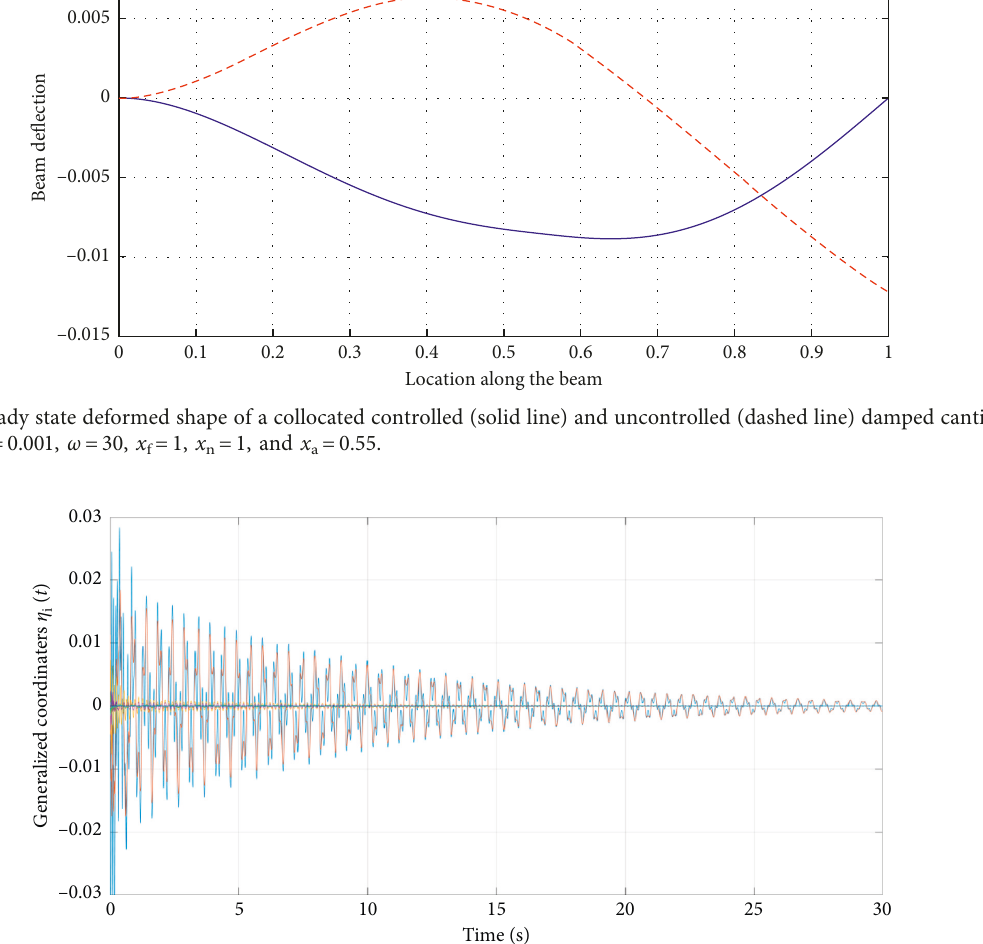
( t ) for the beam system in Figure 2 due to a unit impulse i